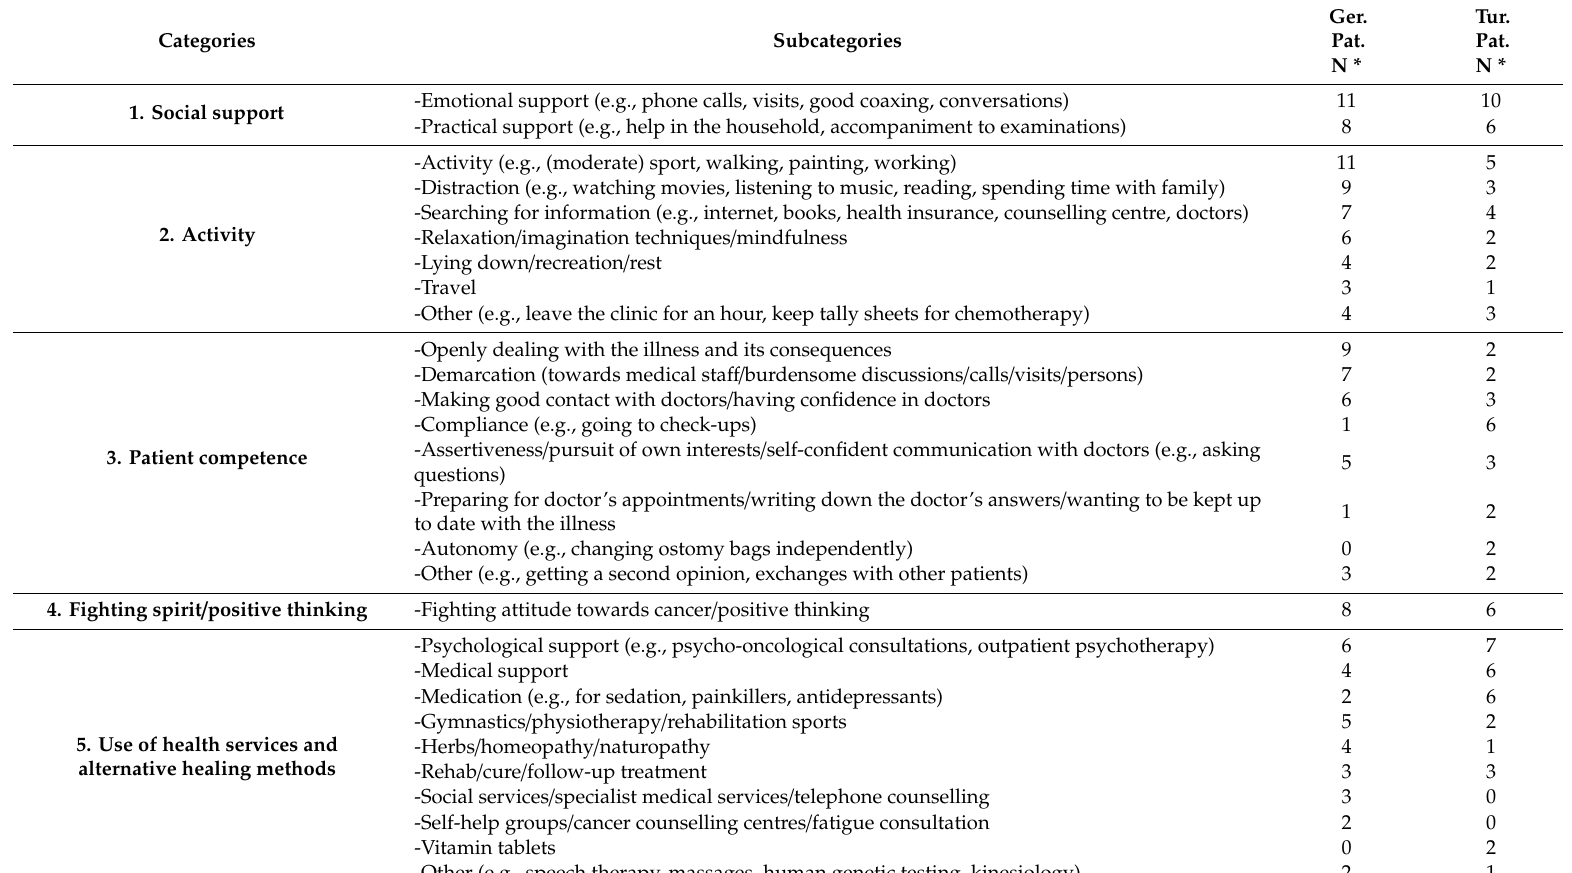
Table 3. Illness coping strategies of German and Turkish cancer